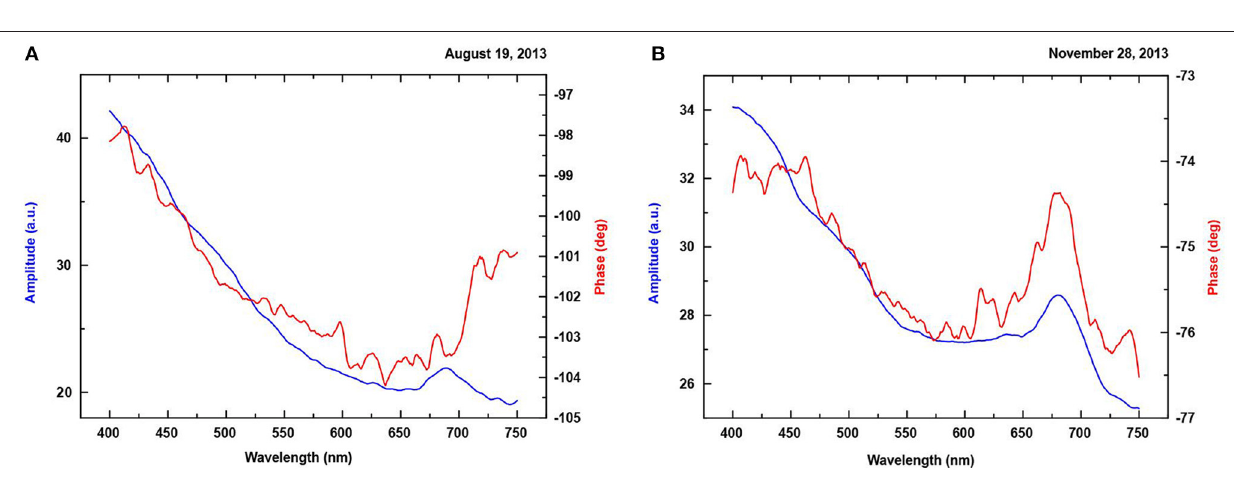
Frontiers in Marine Science |